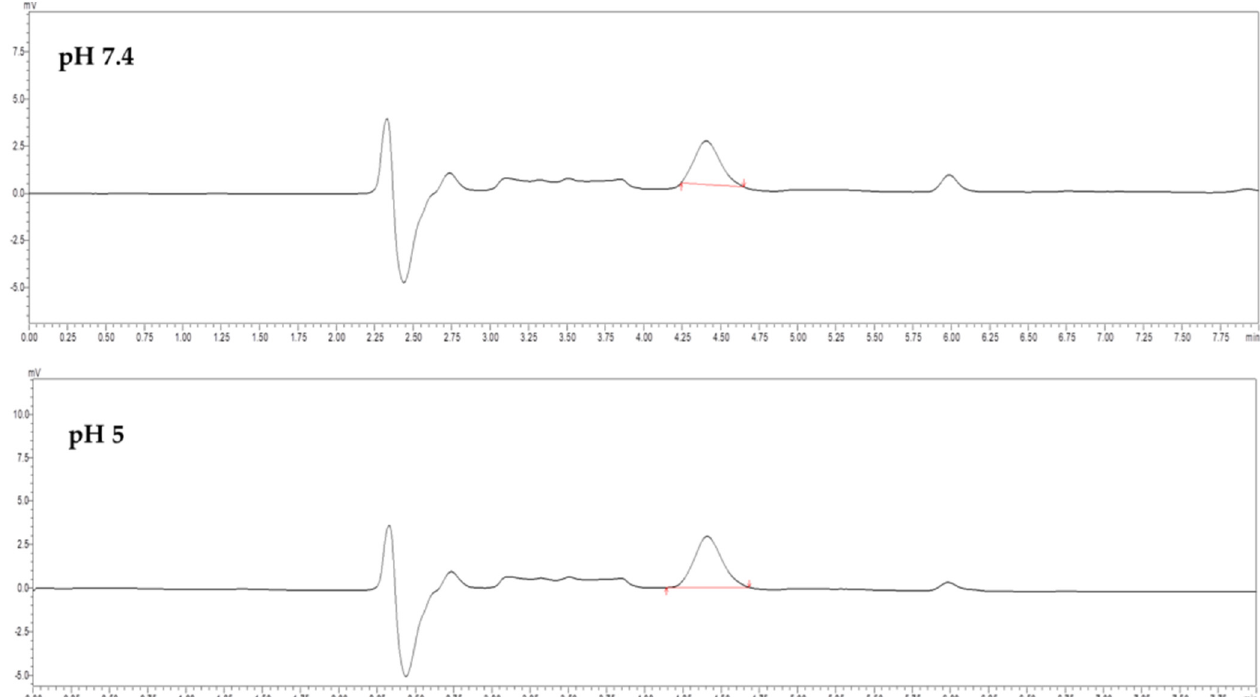
Appl. Sci. 2021 , 11 , 6121 Figure 4. Chromatography of demonstrating the in vitro release kinetics of DOX@MSNs at pH 7.4 and 5.